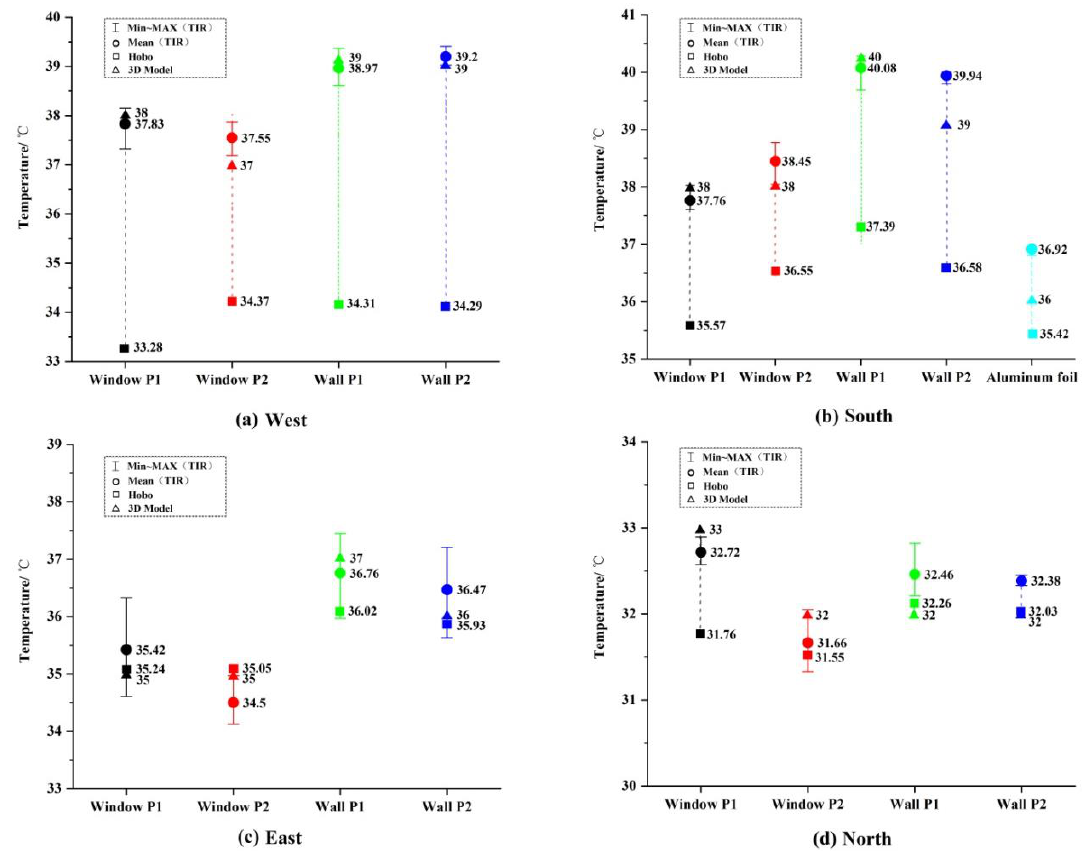
Figure 17. Comparison of temperature by thermocouple, thermal infrared, and 3D model.